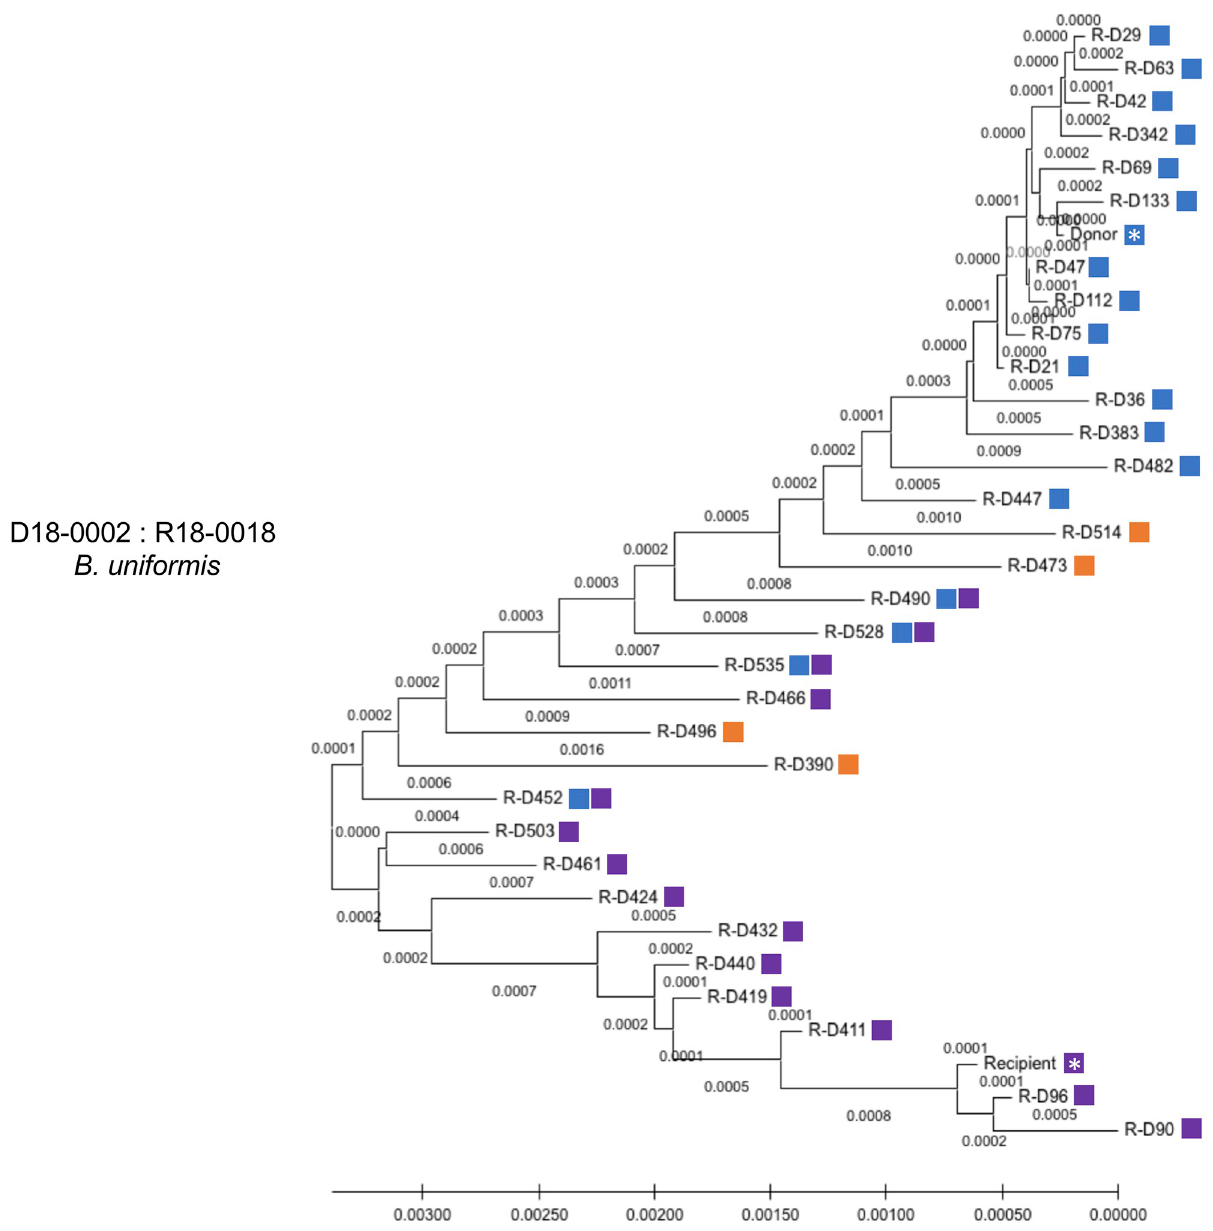
Fig 6. StrainPhlAn analysis for B . uniformis FMT donor 18–0002 and recipient 18–0018 pair. StrainPhlAn analysis on donor 18–0002 and recipient 18–0018 pair was done for B . uniformis across all samples in this pair. A neighbor-joining (NJ) tree was constructed, and the tree is drawn to scale with branch lengths. The same steps which written in the legend of Fig 3 were then applied to complete the tree using MEGA X. The blue and purple boxes displayed next to the NJ tree match the color boxes shown in Fig 5A and the orange color boxes shows a recombinant strain which displayed as both numerical numbers in Fig 5A. A white asterisk indicates a donor and recipient pre FMT